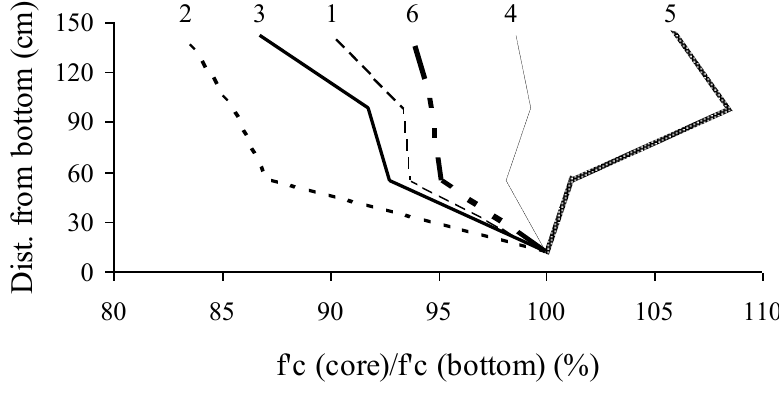
Figure 9. Variations in in-place compressive strengths with height (strength ratio relative to bottom